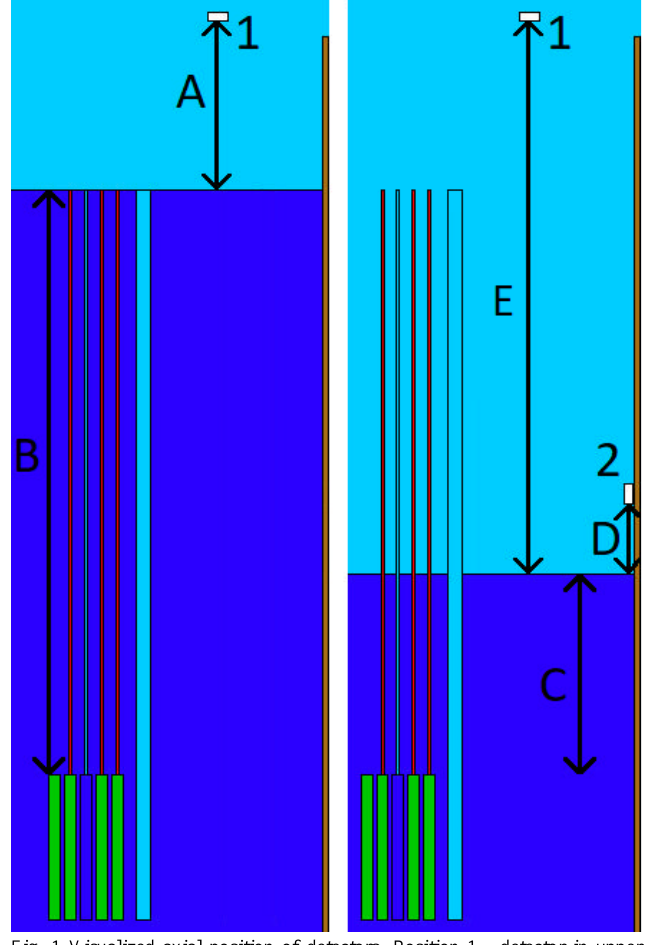
Fig. 1 Visualized axial position of detectors- Position 1 - detector in upper position, position 2 - detector in lower position, distance A is 86 cm, distance B is 306 cm, distance C is 95 cm, distance D is 34 cm, distance E is 291 cm